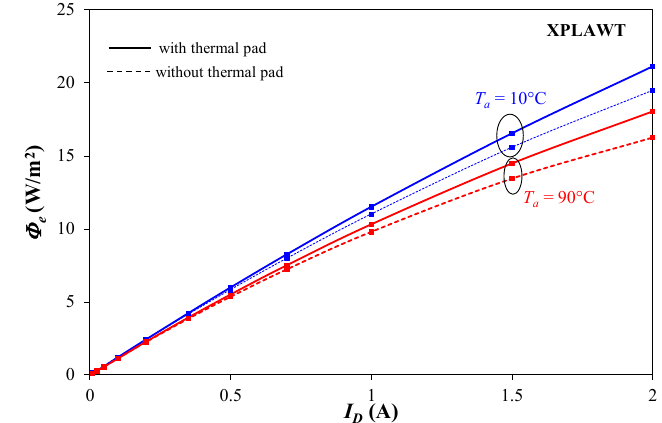
Figure 10. Measured dependences of the surface power density of light emitted by the XPLAWT diode on the LED forward current for different cold plate temperature values.